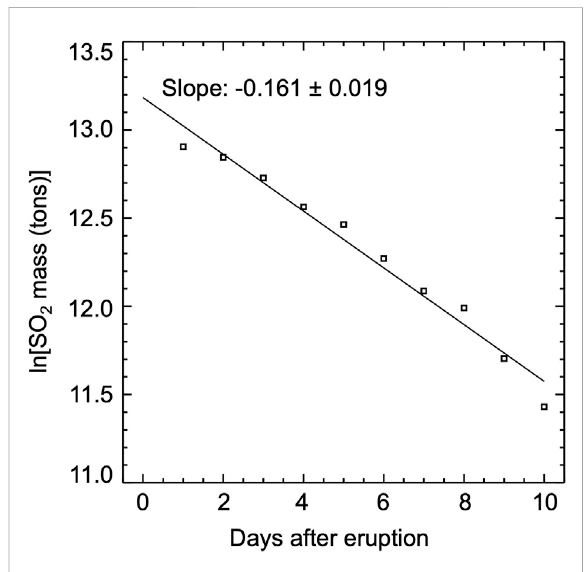
FIGURE 7 Trend in SO 2 mass measured by SNPP/OMPS in the 15 January 2022 HTHH eruption cloud during 10 days of atmospheric residence. The SO 2 mass e-folding time is ~6 days, andextrapolationoftheSO 2 massdecaybacktotheeruption time yields an estimated initial SO 2 mass of 0.54